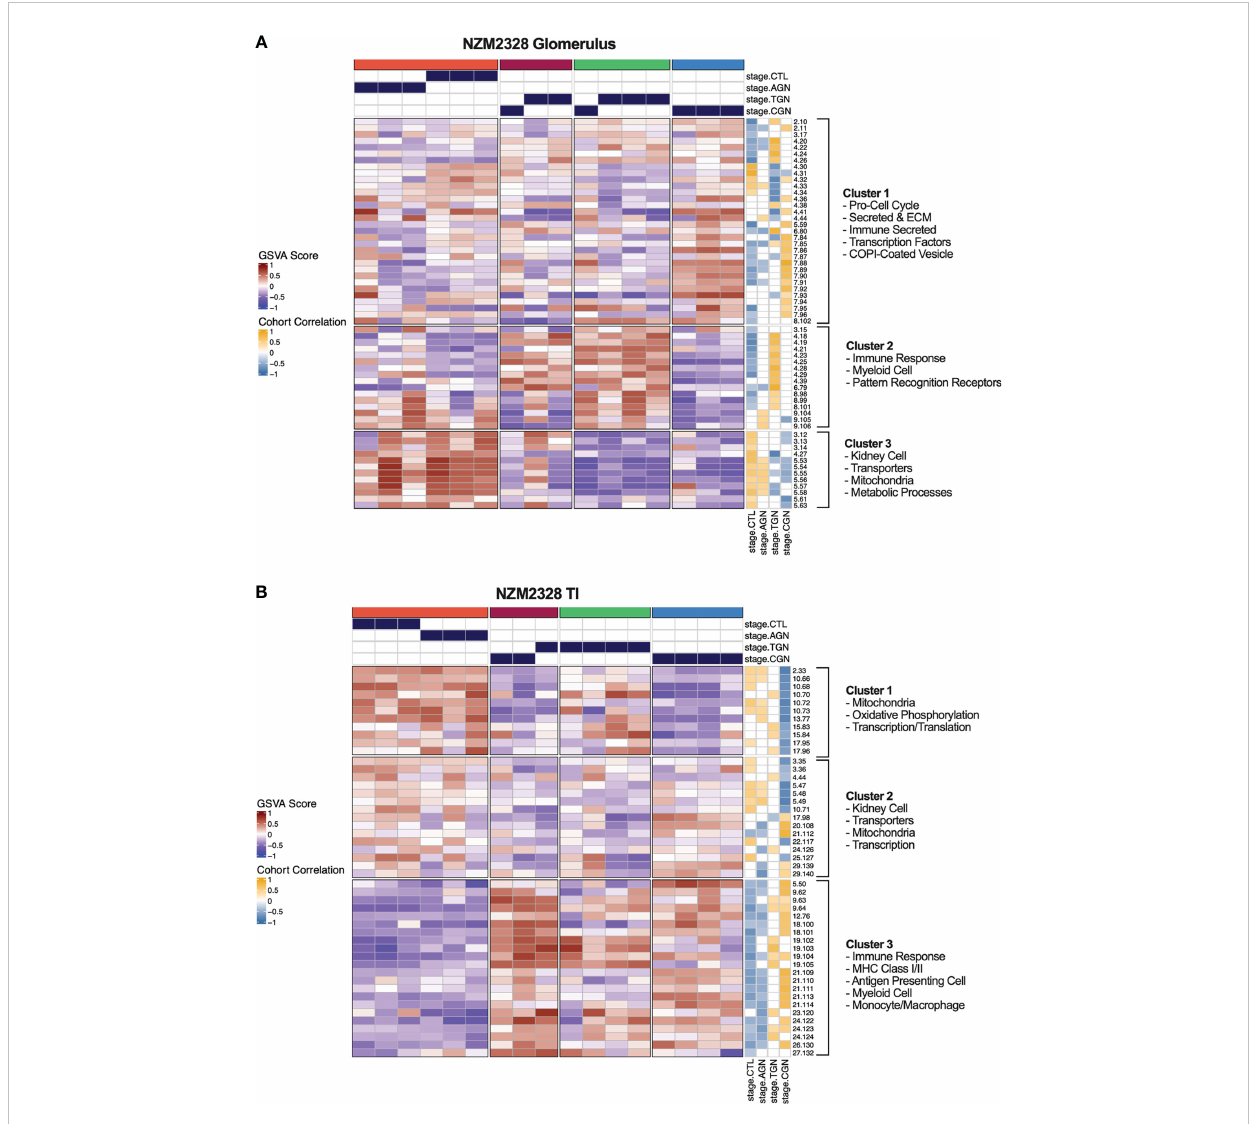
FIGURE 6 Unsupervised gene co-expression network analysis de fi nes molecular pro fi les of NZM2328 mice correlated with disease severity. (A, B) K-means clustering (k=4) of NZM2328 CTL, AGN, TGN, and CGN mouse glomeruli (A) and TI (B) based on GSVA enrichment scores of MEGENA modules. The optimal number of module clusters was de fi ned by the silhouette method and annotated by gene overlap with curated immunologic signatures and GO terms. Heatmap visualizations depict positive to negative GSVA scores on a red to blue gradient and positive to negative correlations between GSVA scores and disease classi fi cation on a gold to blue